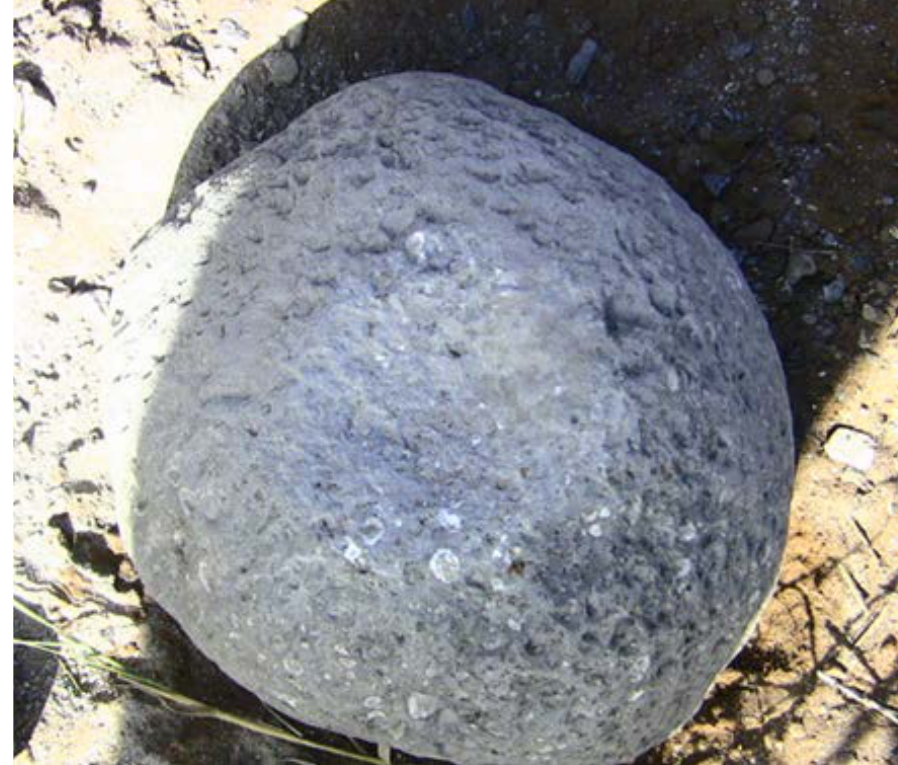
Figure 3. The shallow cavity becoming visible after rough and fine